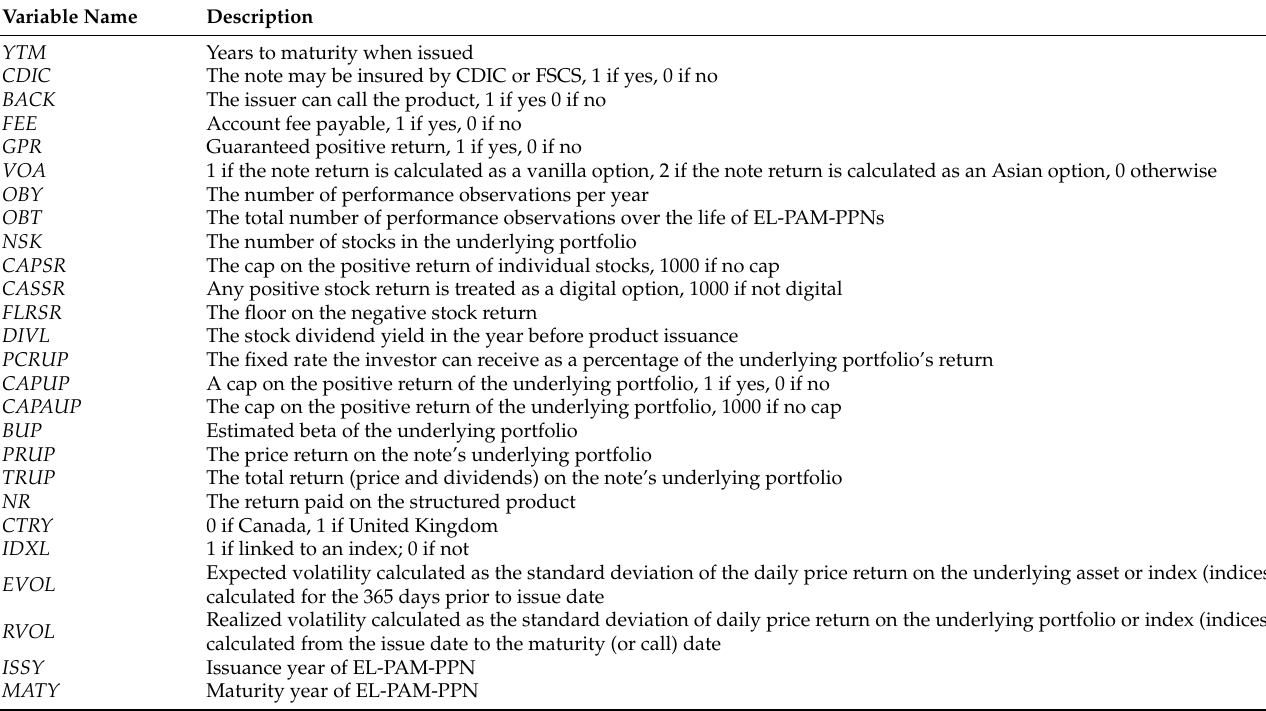
Table 1. Definition of